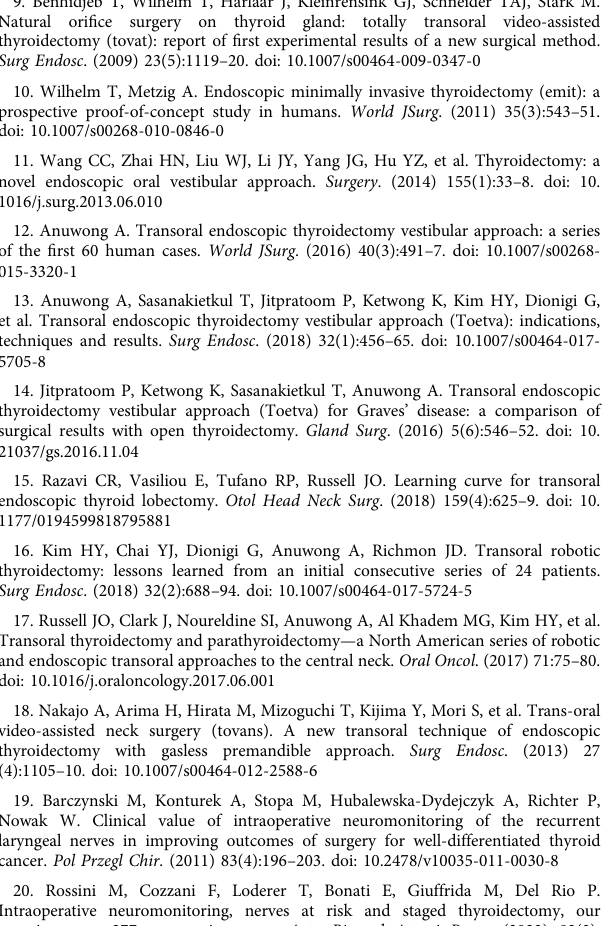
curve: a regression analysis of complication rates and severity. Surg Endosc . (2022) 36(7):4839 – 44. doi: